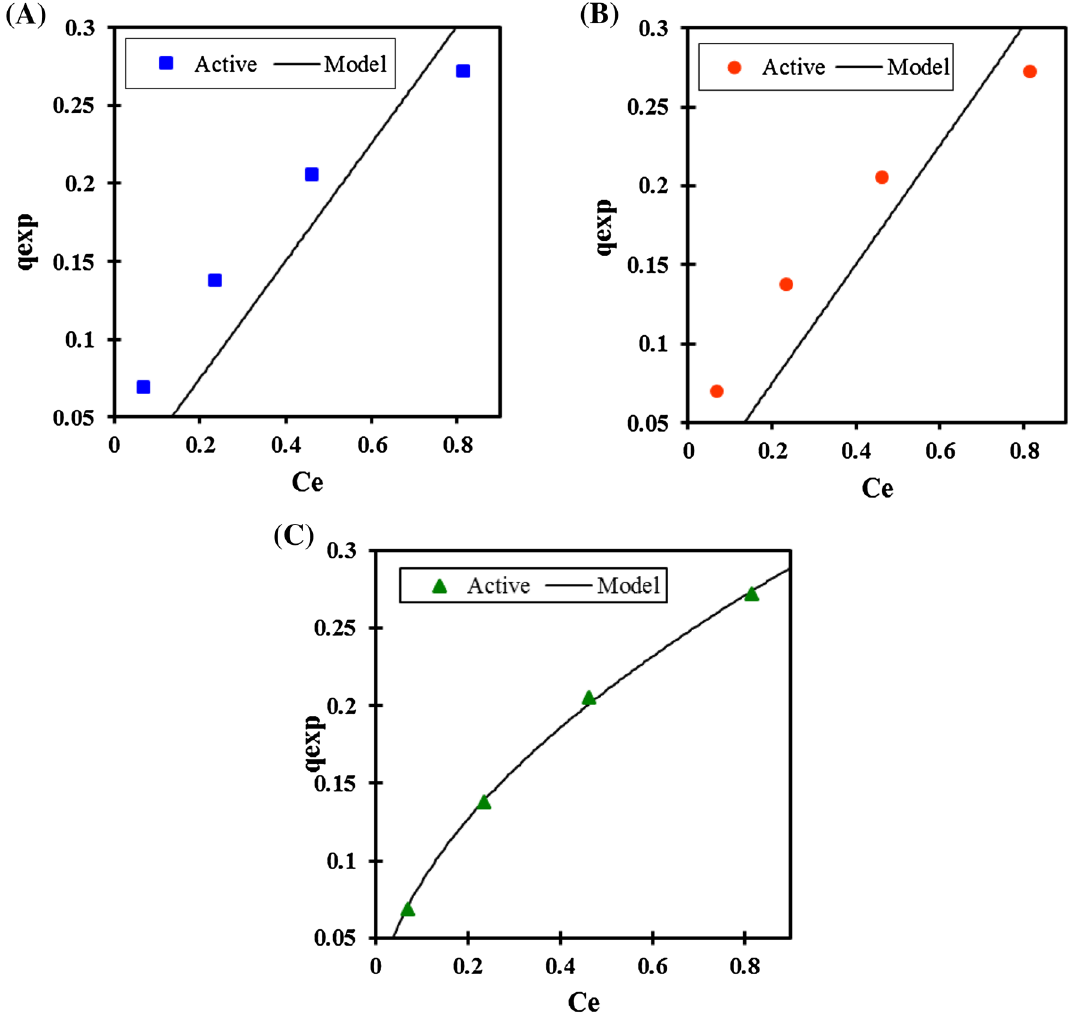
Fig. 4 Isotherms obtained using the non-linear method for the fluoride adsorption onto Bio-F: a Langmuir, b Freundlich, c